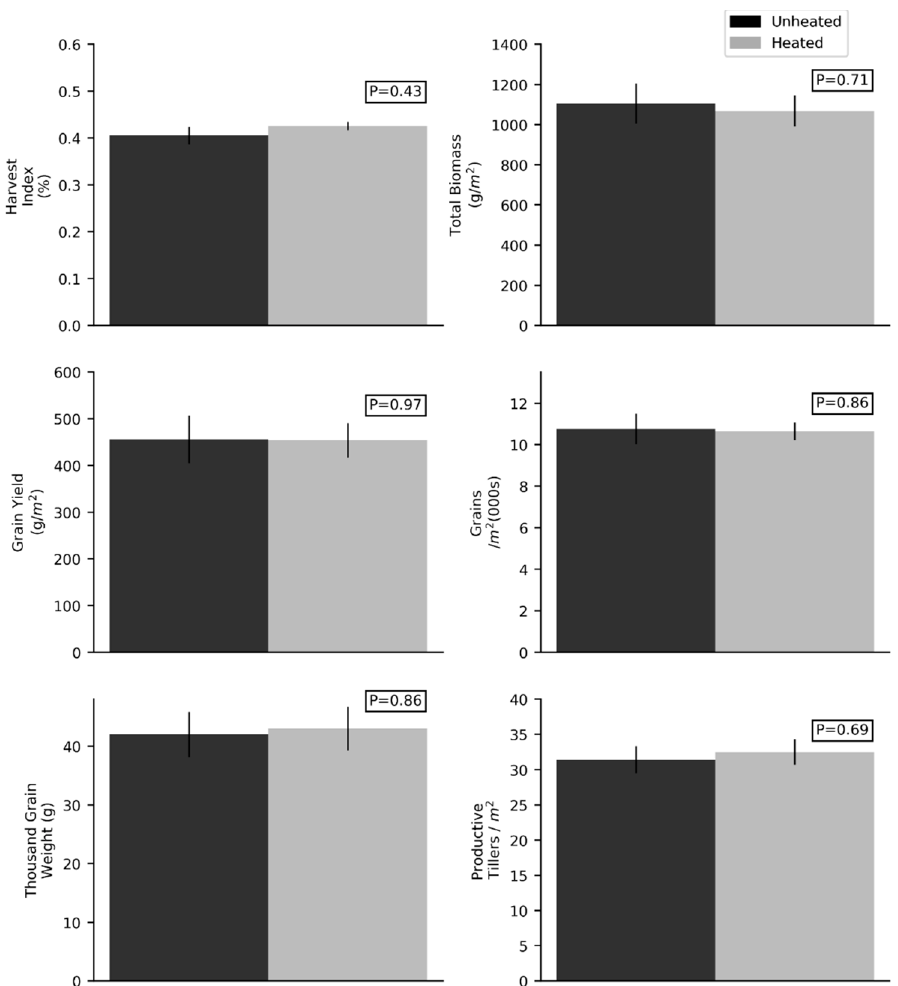
Figure 9. Mean HI, total biomass(g/m 2 ), grain yield (g/m 2 ), number of grains per m 2 , thousand grain weight and number of productive tillers per m 2 for the 6 heated plots and non-heated mirror plots for 2017, with error bars representing standard error of the mean. p -value results from a paired t -test are report for the difference between the means. ( n = 6).